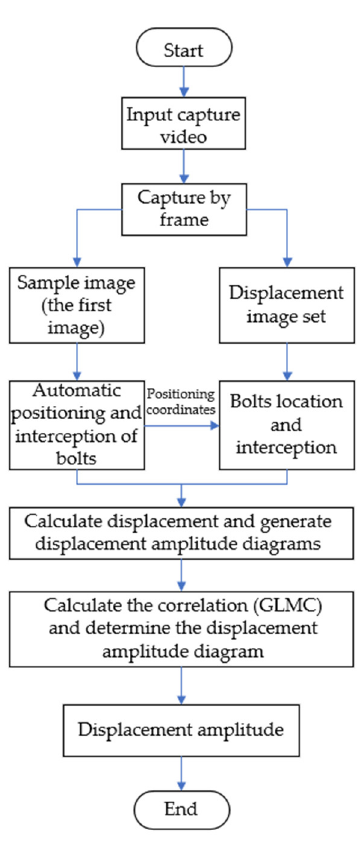
Figure 5. Flow chart of displacement identification.